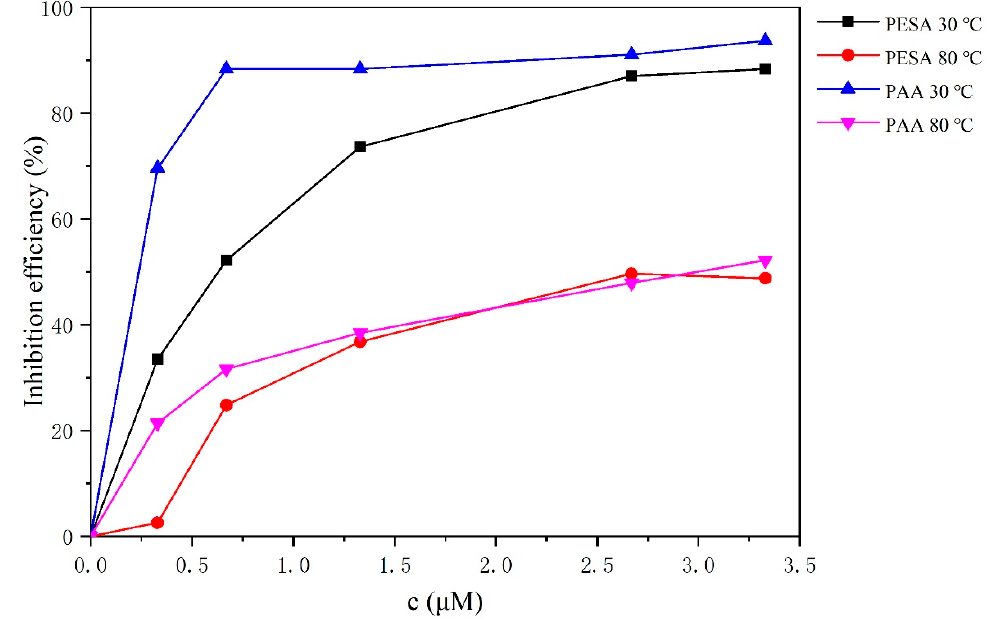
Figure 1. The inhibition efficiency of the two inhibitors at 30 °C and 80 °C.